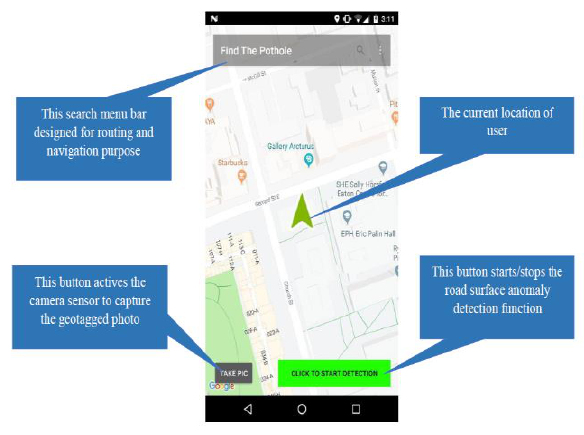
Figure 3. The main interface of the developed Mobile GIS application and its